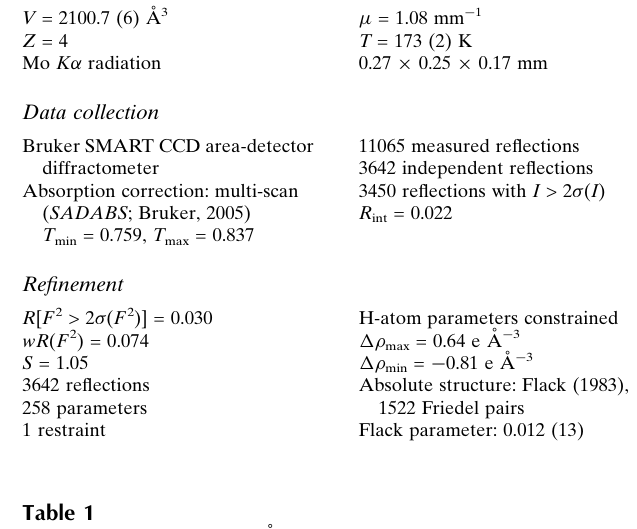
Hydrogen-bond geometry (A˚ , (cid:1)